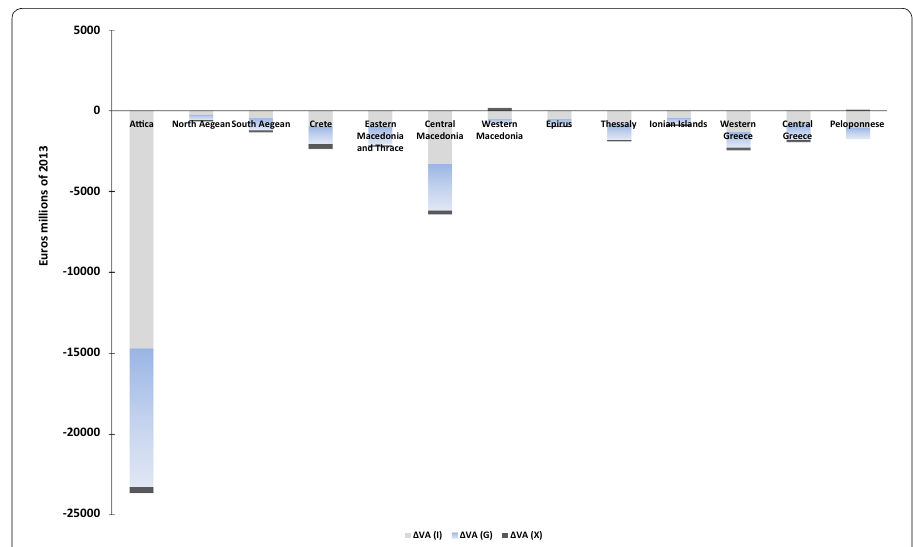
Fig. 4 GRP changes driven by final demand categories: Greece, 2010–2013. The figure represents the changes associated to each final demand component together with value-added input-coefficient change and direct-coefficient change. To have the contribution of each final demand component, we have considered each of them separately in the decomposition of changes in value-added, according to Eq.